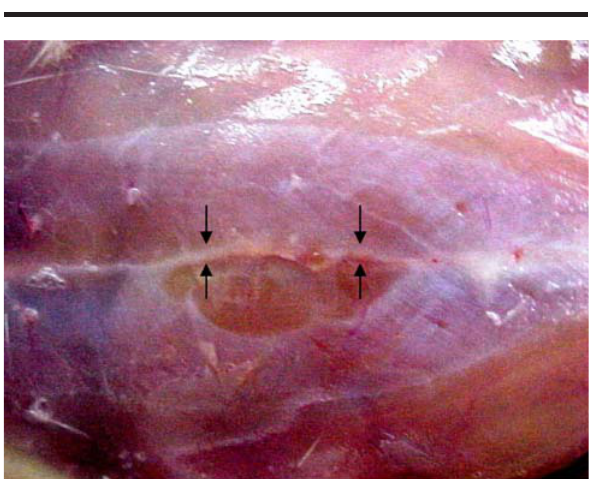
FIGURA 2A - Perfil do rato do subgrupo em que foi aplicado o ultra-som por 28 dias, sem hérnia incisional.